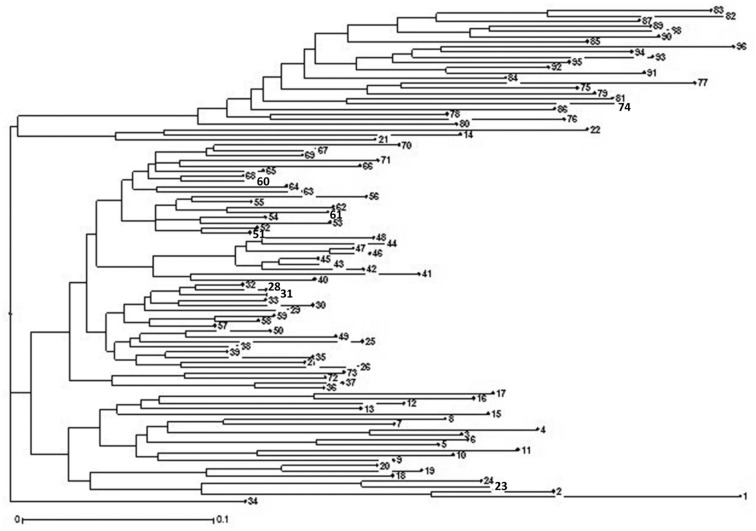
Neighbour joining dendrogram of 96 genotype of lentil with 73 SSRs (Serial number of genotype in the figure corresponds with serial number and genotype in Table 1).